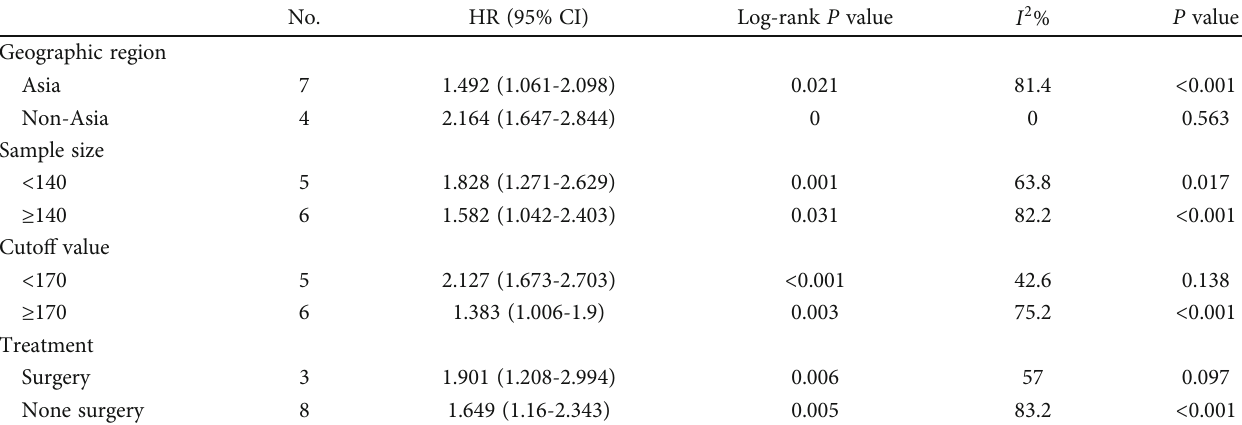
Table 2: Subgroup analysis for the association between elevated preoperative PLR and prognosis of patients with colorectal cancer.